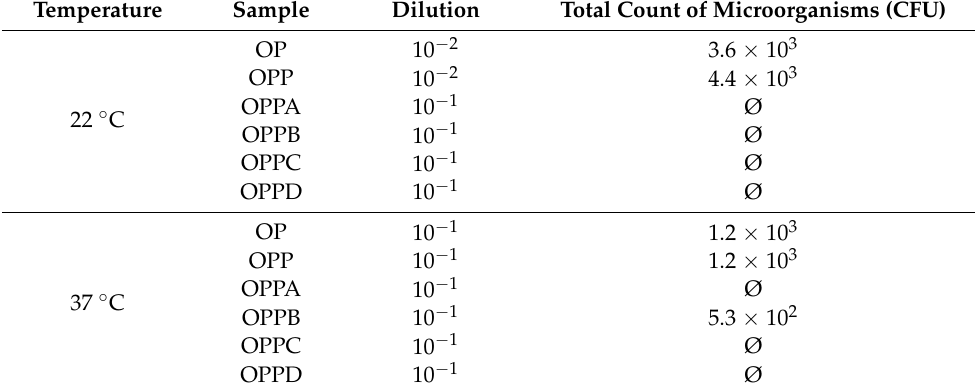
Table 5. Total count of microorganisms at 22 ◦ C and 37 ◦ C (48 h) of olive pomace samples. Temperature Sample Dilution Total Count of Microorganisms (CFU) OP 10 −